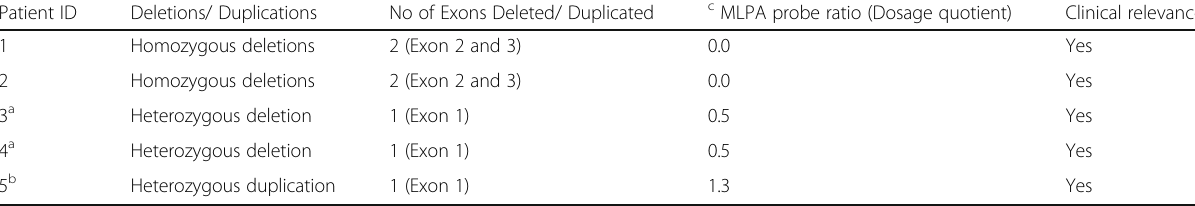
Table 2 MPLA analysis for deletion/duplication study of HEXA gene Patient